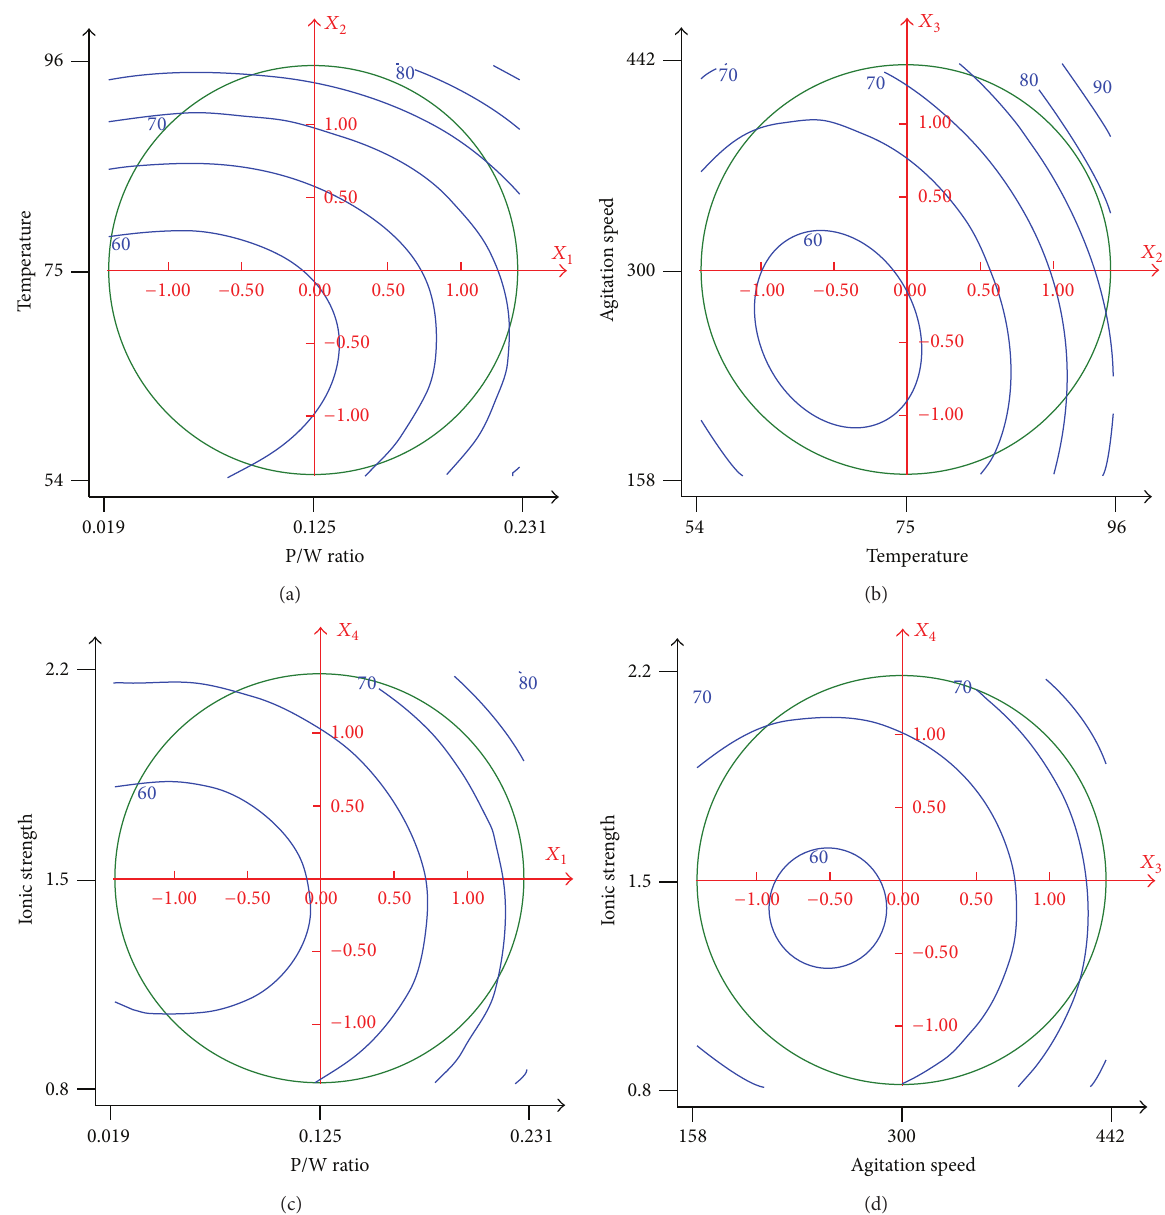
Figure 4: Contour plots illustrating the effect of (a) temperature and P/W ratio at constant agitation speed (300 rpm) and ionic strength (1.5g/L), (b) temperature and agitation speed at constant P/W ratio (0.125) and ionic strength (1.5 g/L), (c) ionic strength and P/W ratio at constant agitation speed (300rpm) and temperature (75 ∘ C), and (d) ionic strength and agitation speed at constant P/W ratio (0.125) and temperature (75 ∘ C) on soluble fibres yield extracted from dried Agave leaves’